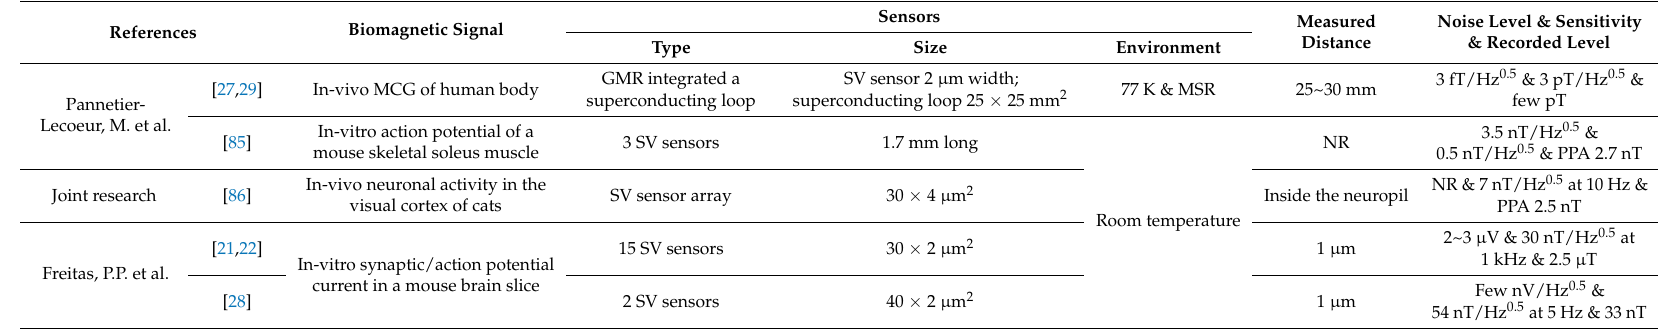
Table 1. Representative studies on integrated GMR system for biomagnetic signal